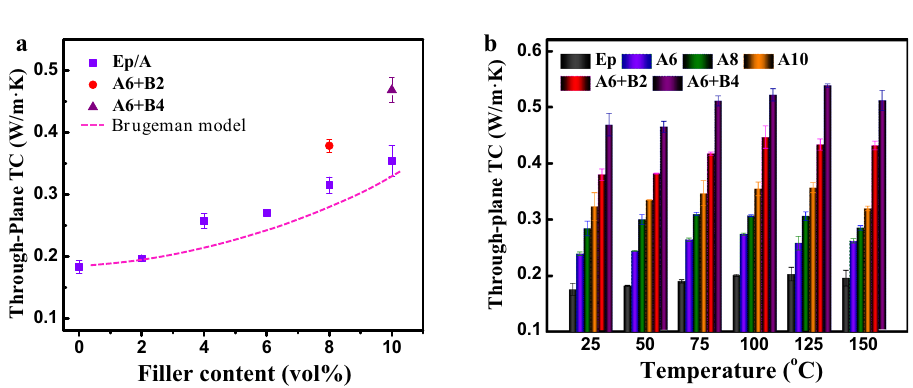
Figure 2. Cross-section SEM morphology of ( a ) A8, ( b ) A6 + B2, and ( c ) XRD patterns of epoxy composites with individual or hybrid fillers.